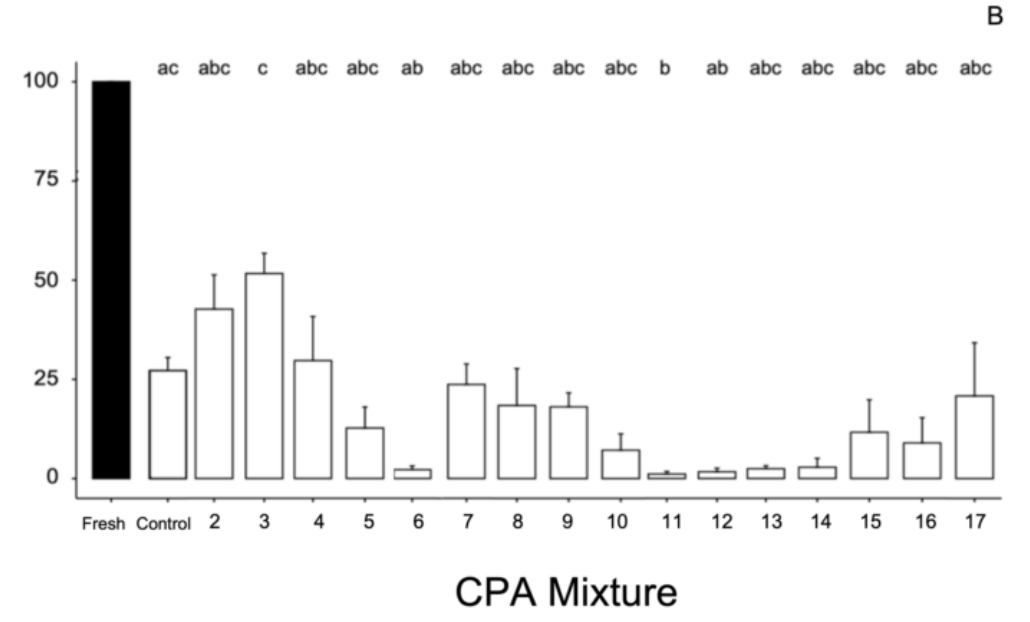
Figure 1. Barplot ( A ): percent total motility of post-thaw sperm of the Louisiana pinesnake cryopreserved using 17 different CPA treatment mixtures; ( B ) percent viability of thawed sperm recovered from fresh sperm. Full CPA treatment recipes are reported in Table 1 as final concentrations following a 1:1 dilution ( v / v ) with semen. Four randomized groupings of males were used to test the CPA control mixture (control) and a set of CPA treatment mixtures (Group A = CPAs #3, 4, 5, 7; Group B = CPAs #2, 14, 15, 16; Group C = CPAs #6, 11, 12, 13; Group D = CPAs #8, 9, 10, 17). We tested CPA mixtures based on three categories of experimental tests: CPA base in TEST = CPA #2; Extender base plus additives = CPAs #3–8; and glycerol tests (high vs low) = CPAs #9–17). The bars represent the means and standard deviation for each experimental group. Kruskal–Wallis tests for significance followed by Dunn’s post-hoc test with the Benjamini–Hochberg correction for multiple comparisons to compare CPA treatments; alpha was set at 0.05. The letters above each bar represent significantly different groups, and the black filled bars represent fresh samples and were not included in the statistical